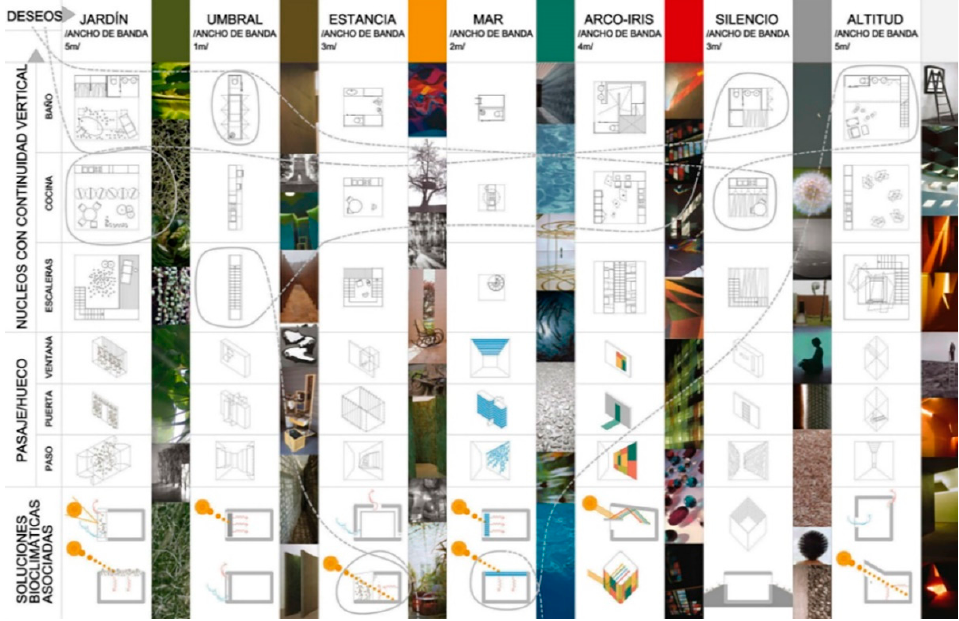
Figure 1. Fabric of Happiness , Europan 7, La Unión, Murcia, Spain. Drawing: Gálvez +